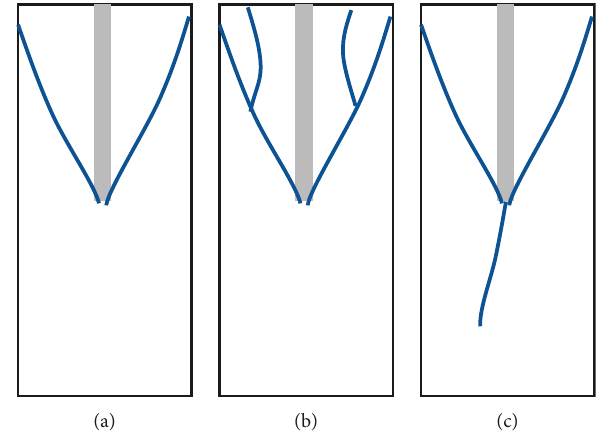
Figure 11: Macrofailure mode sketch. (a) Type 1. (b) Type 2. (c) Type